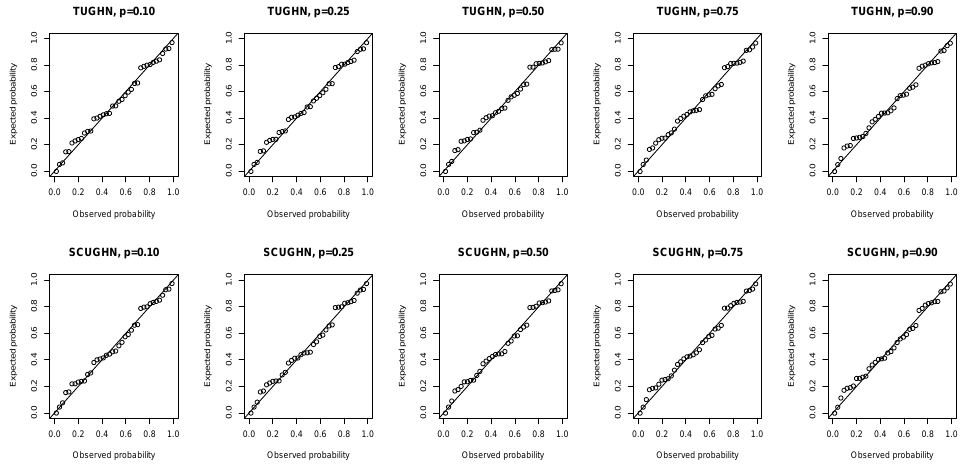
Figure 7. P–P plots of randomized quantile residuals of the TUGHN and SCUGHN regression models.